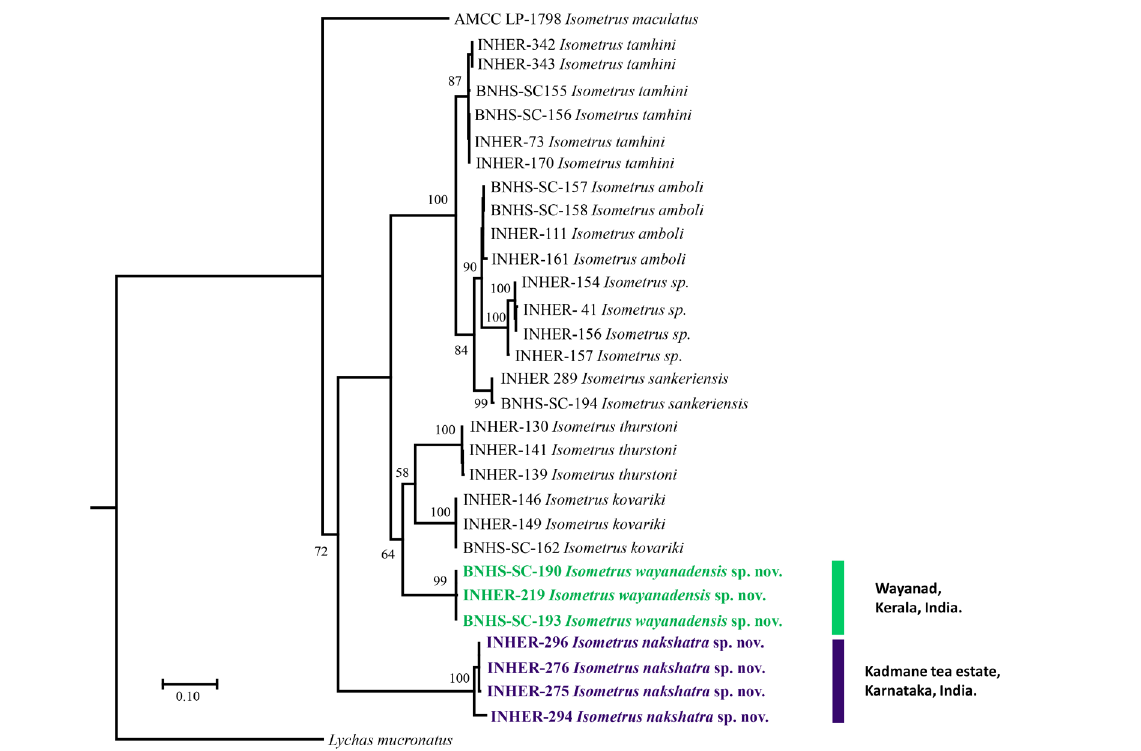
Fig. 2. Maximum Likehood phylogenetic tree (ML) for Isometrus Ehrenberg, 1828. Values along the nodes are bootstraps for 1000